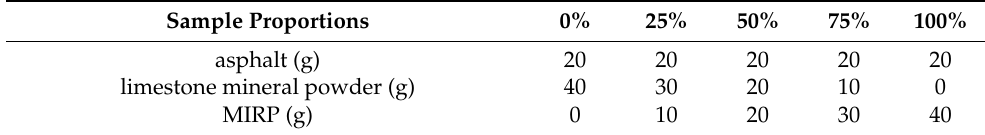
Table 4. Asphalt slurry specimen